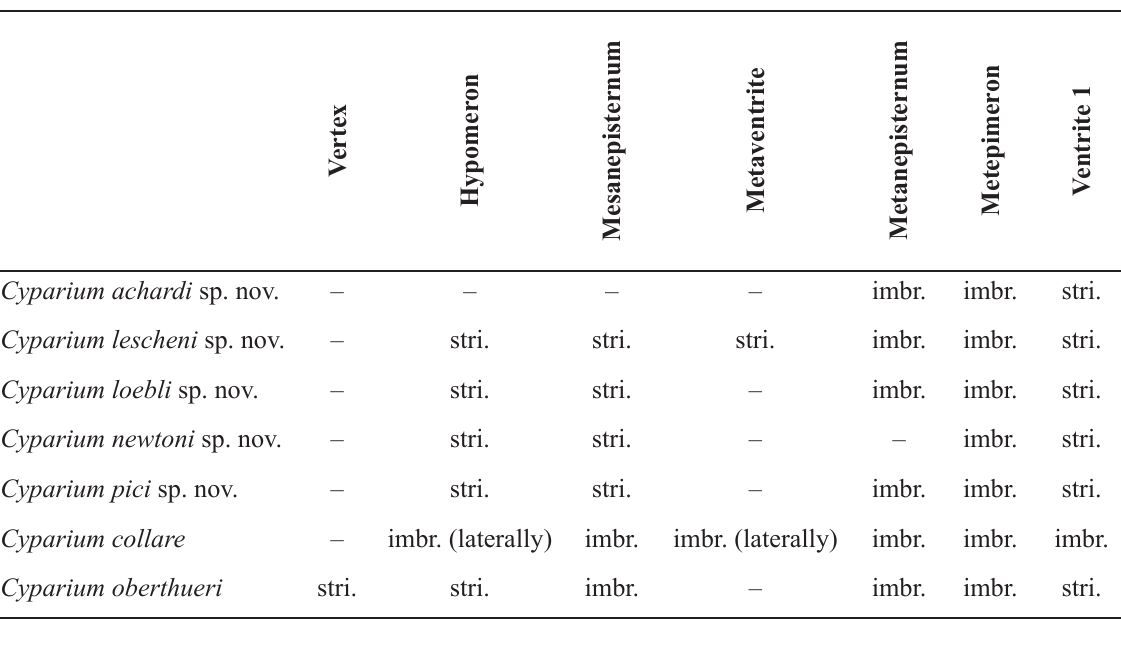
Table 1. Comparative morphology regarding the microsculpture of the various structures. Abbreviations: stri. = strigulate; imbr. =